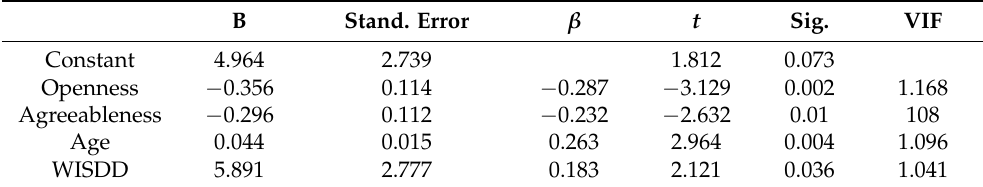
Table 3. Regression model with Ethnic identity as dependent variable. B Stand. Error